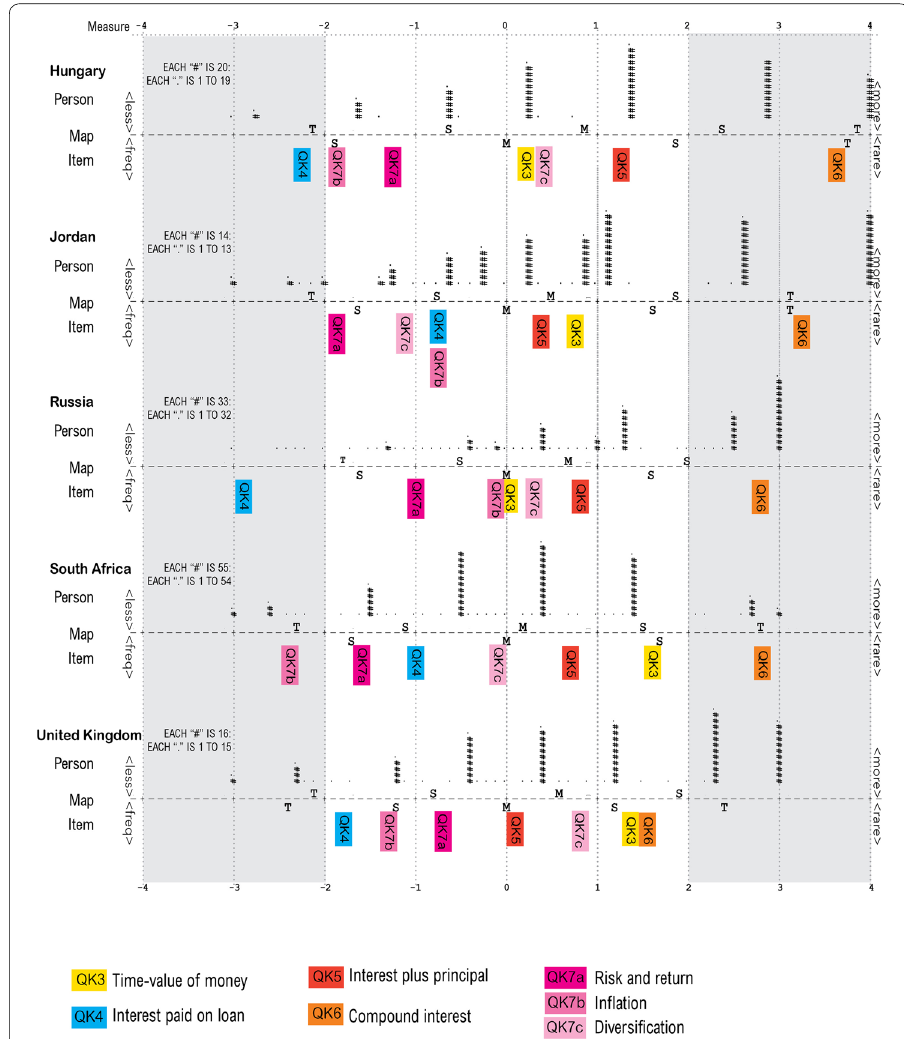
Fig. 4 Wright maps: financial knowledge assessment. Wright maps portray the two dimensions of (i) ability of the respondents and (ii) difficulty of the questions on one illustration. The placement of the respondents ability compared to the difficulty of the questions give an indication of how closely (or not) the participants abilities are compared to the difficulty of the measurement